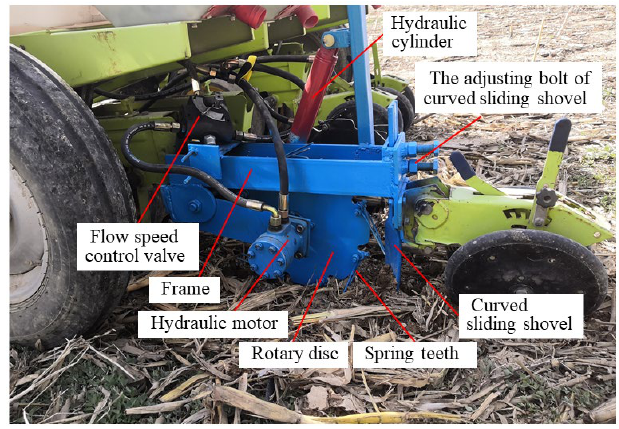
Figure 14. Field experiment of no-till seed furrow clearing device.